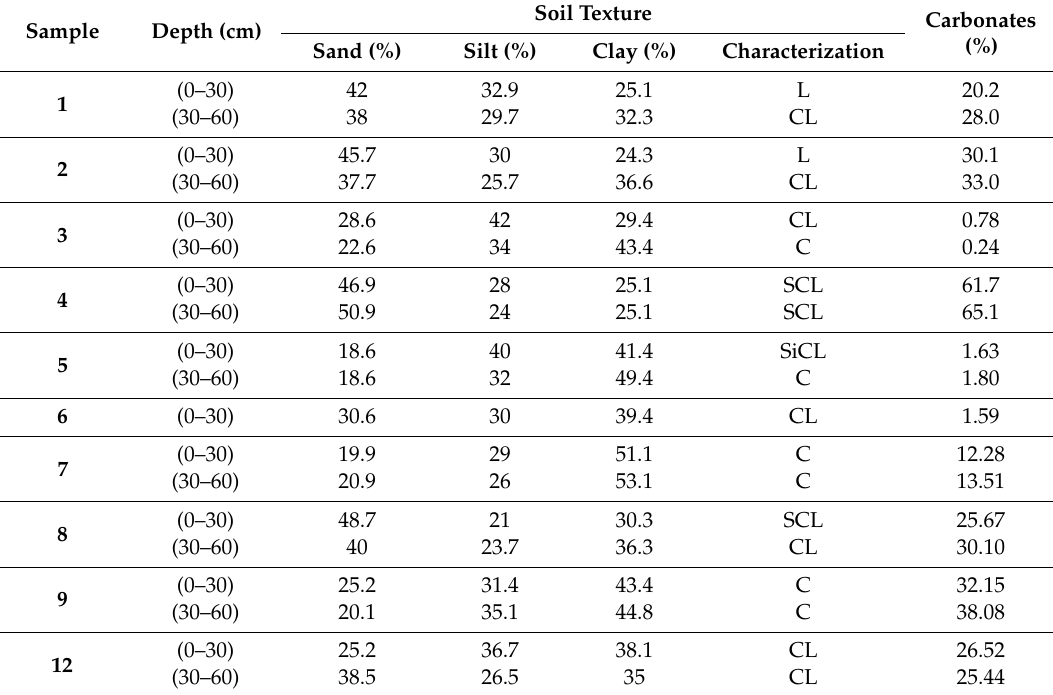
Table A19. Soil analyses of the 20 soil samples of the 12 soil sampling sites of the 2019 mapping system.